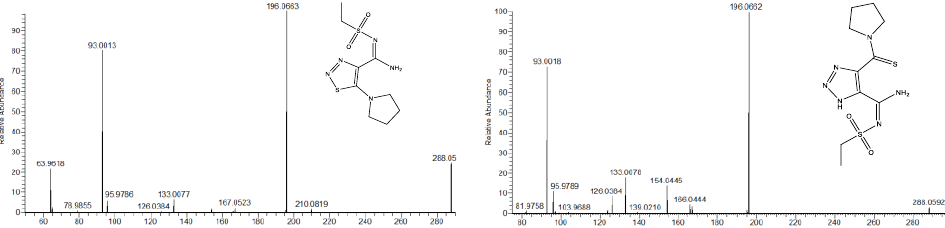
Figure 6. Example of tandem mass spectra of isomeric deprotonated 1,2,3-thiadiazole and 1,2,3-triazole in negative ion mode (compounds 1cS and 1cN , respectively).